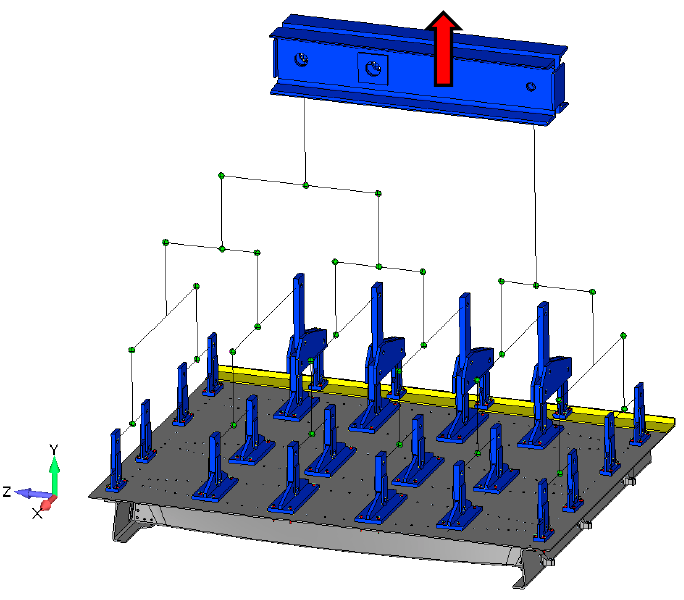
Figure 7. CAD model of the whiffle tree system for load distribution into the door panel.